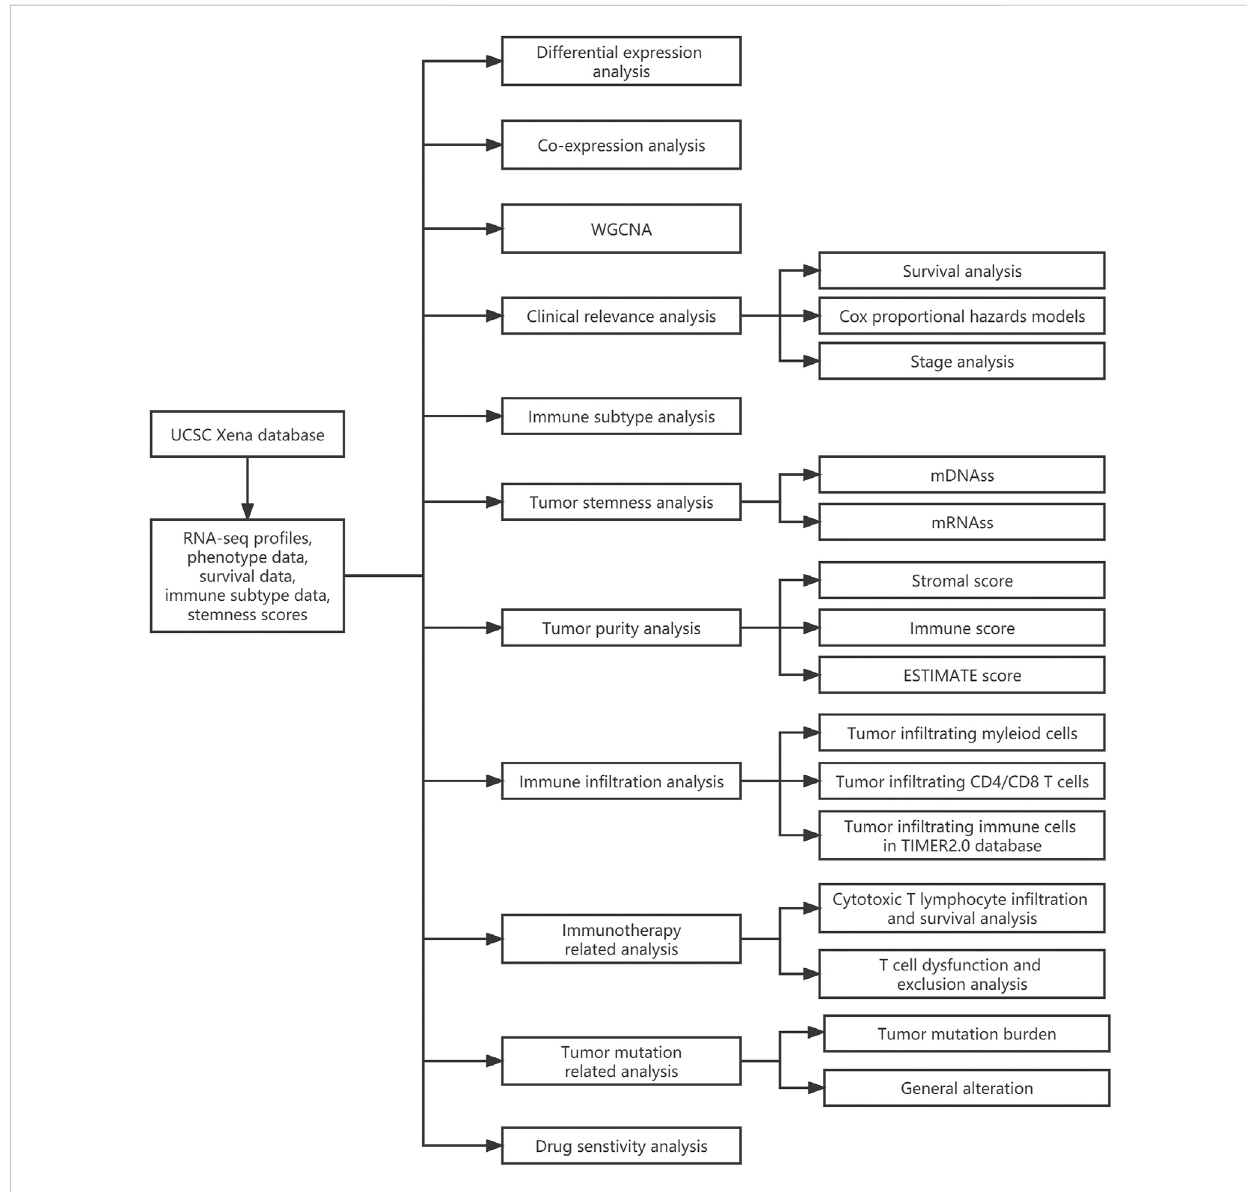
FIGURE 1 The fl owchart of the whole analytic process of our